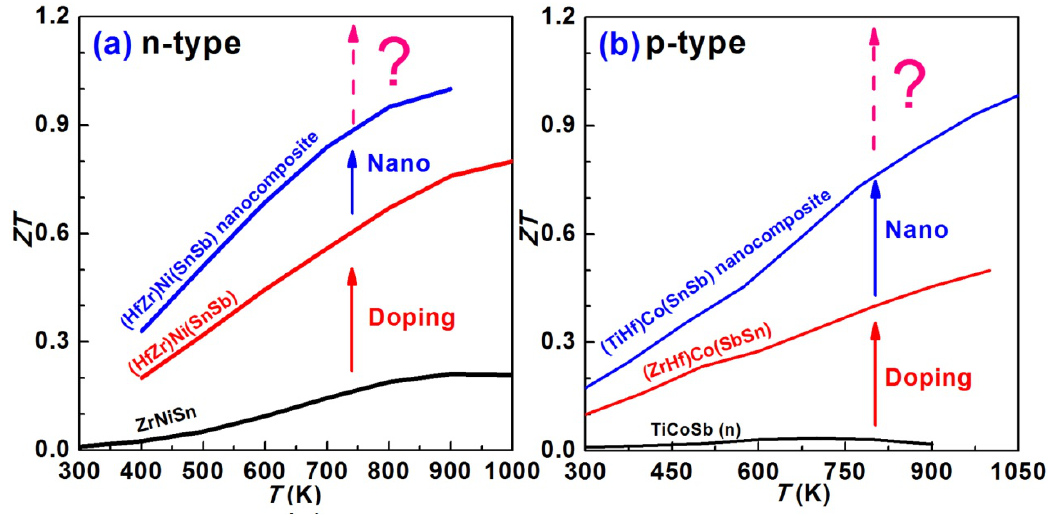
Figure 21. The ZT values of HH compounds are significantly enhanced by doping